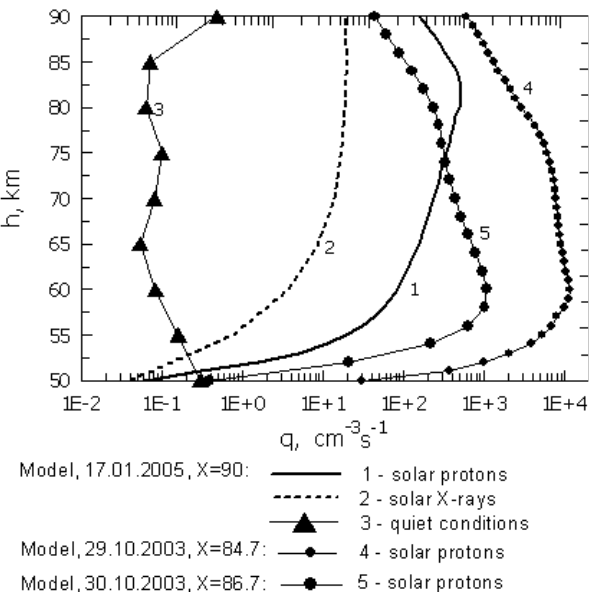
Fig. 4 . Ion pair production rate profiles produced in the lower iono- sphere with solar proton fluxes in the energy range 2.4–100MeV (curve 1), solar X-rays (curve 2) and in quiet conditions (curve) calculated for 09:50UT on 17 January 2005. Curve 4 and 5 – ion pair production rate profiles produced with solar proton fluxes at 10:00UT on 29 October 2003 and 09:00UT on 30 October